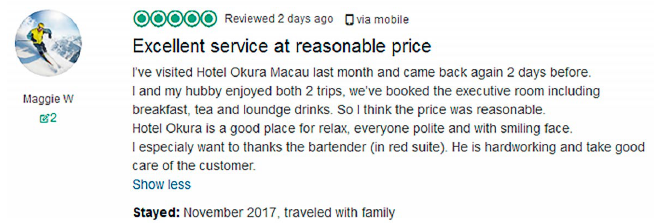
Figure 4. An online review for Okura Macao Hotel from